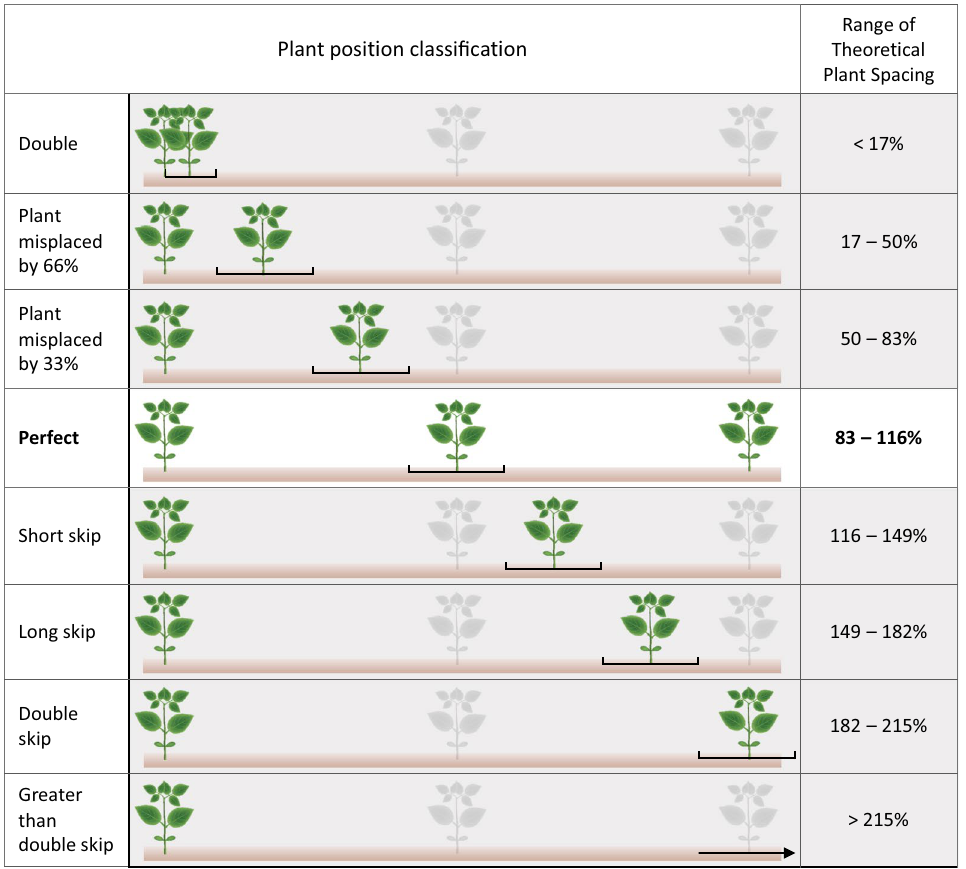
Figure 1. Plant position classification based on the observed spacing to the previous plant within a row compared to the theoretical plant spacing (TPS). The TPS is the targeted (perfect) plant spacing of a plant population given a seeding rate and row width. The difference between TPS and observed spacing to the previous plant was rated as double (< 17.5% of TPS); misplaced by 66% (between 17.5–50.5% of TPS), misplaced by 33% (between 50.5–83.5% of TPS), perfectly spaced plants (between 83.5–116.5% of TPS), short-skip plant (between 116.5–149.5% of TPS), long-skip plants (between 149.5–182.5% of TPS), double-skip plants (between 182.5–215.5% of TPS), and greater than double-skip plants (> 215.5% of